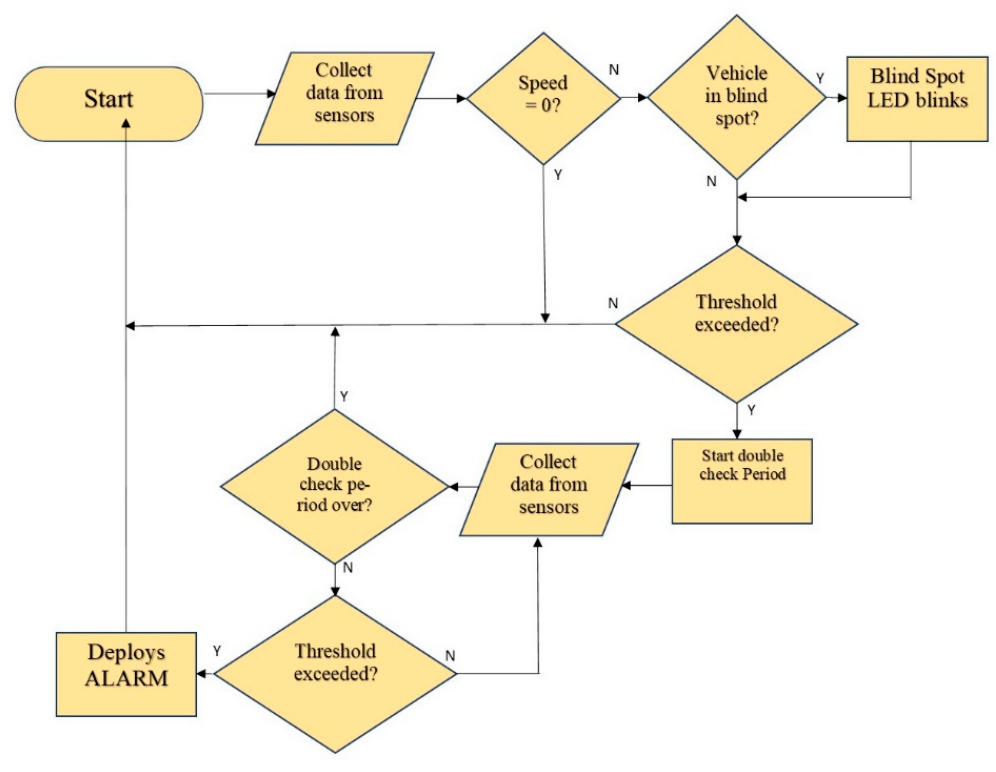
Figure 6. NoSleep sensor flowchart.